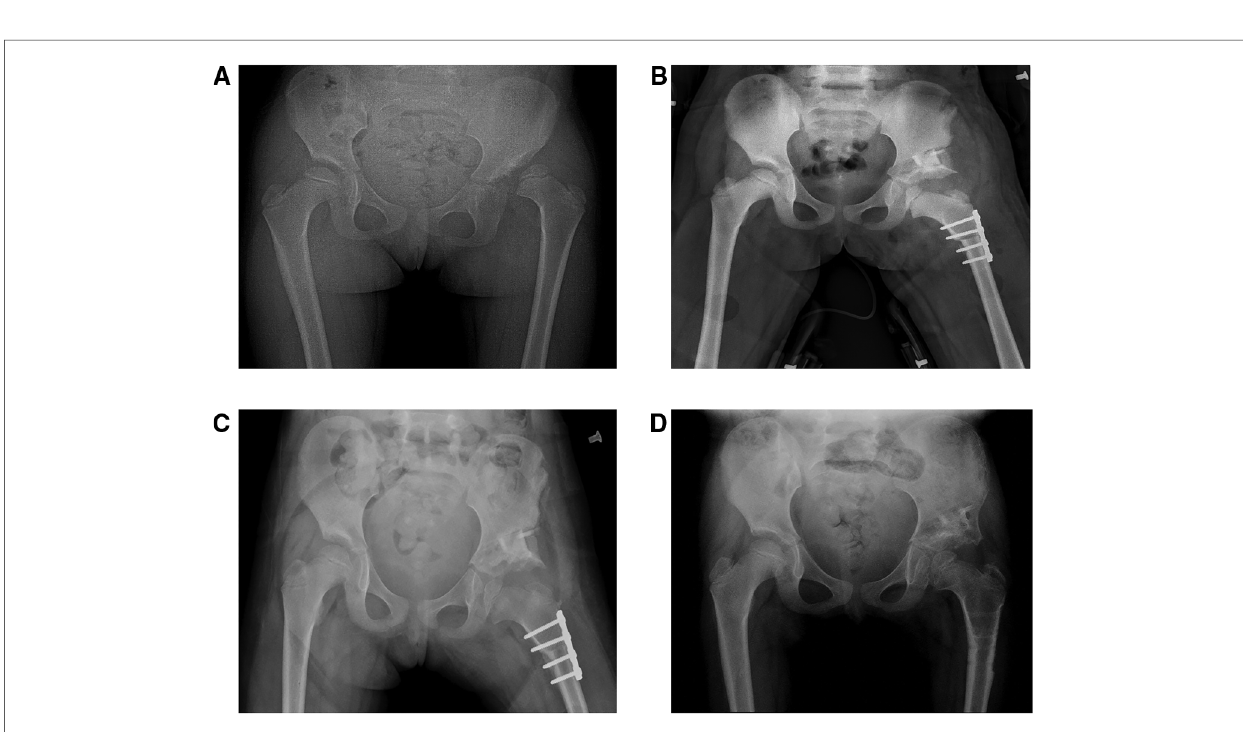
FIGURE 5 A girl, aged 6 years and 8 months, with Tönnis II dislocation of her left hip, underwent a Pemberton osteotomy combined with femoral shortening osteotomy. ( A ) Preoperative hip anteroposterior (AP) radiograph: left hip dislocation. ( B ) AP radiograph obtained three days after the Pemberton osteotomy combined with femoral shortening osteotomy; the length of the femoral osteotomy is 2 cm. ( C ) AP radiograph obtained 1.5 months after the Pemberton osteotomy combined with femoral shortening osteotomy. ( D ) AP radiograph obtained 12 months after the Pemberton osteotomy combined with femoral shortening osteotomy and 2 months after removal of internal fi